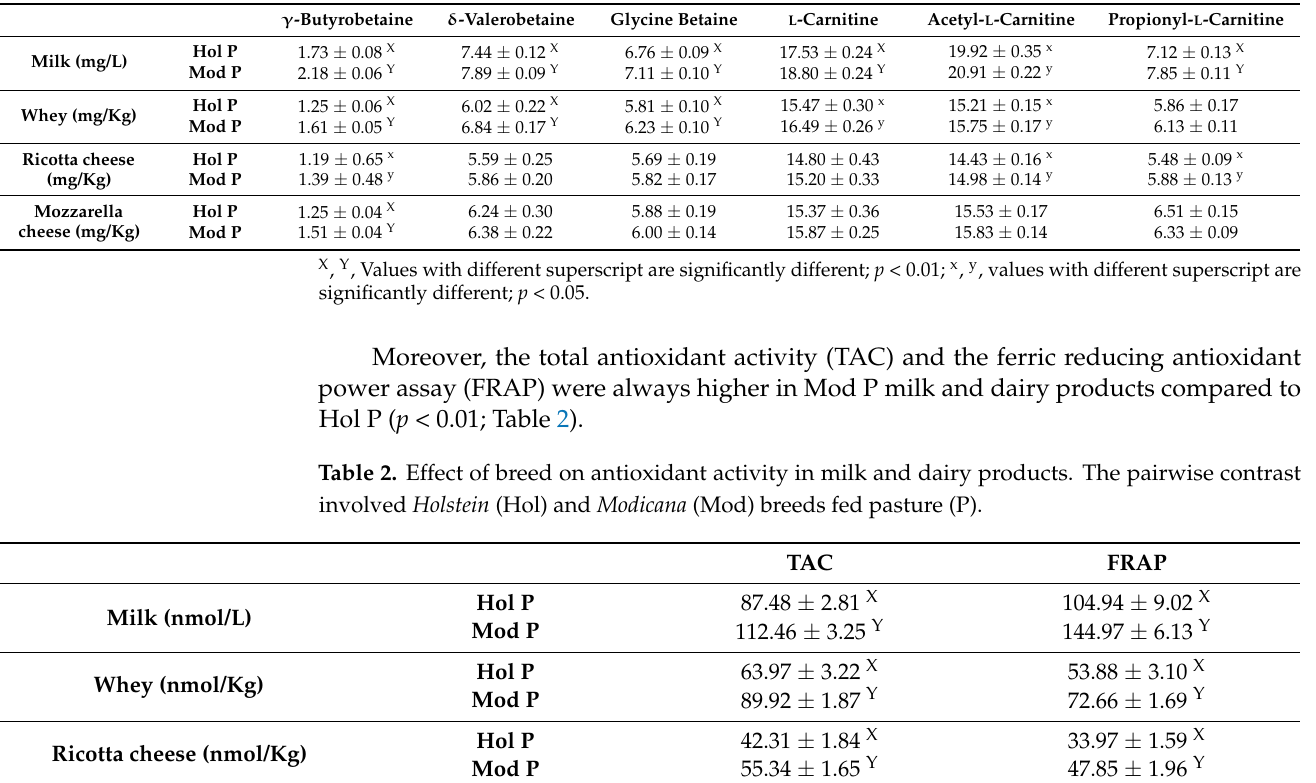
Table 1. Effect of breed on health-promoting biomolecules in milk and dairy products. The pairwise contrast involved Holstein (Hol) and Modicana (Mod) breeds fed pasture (P).